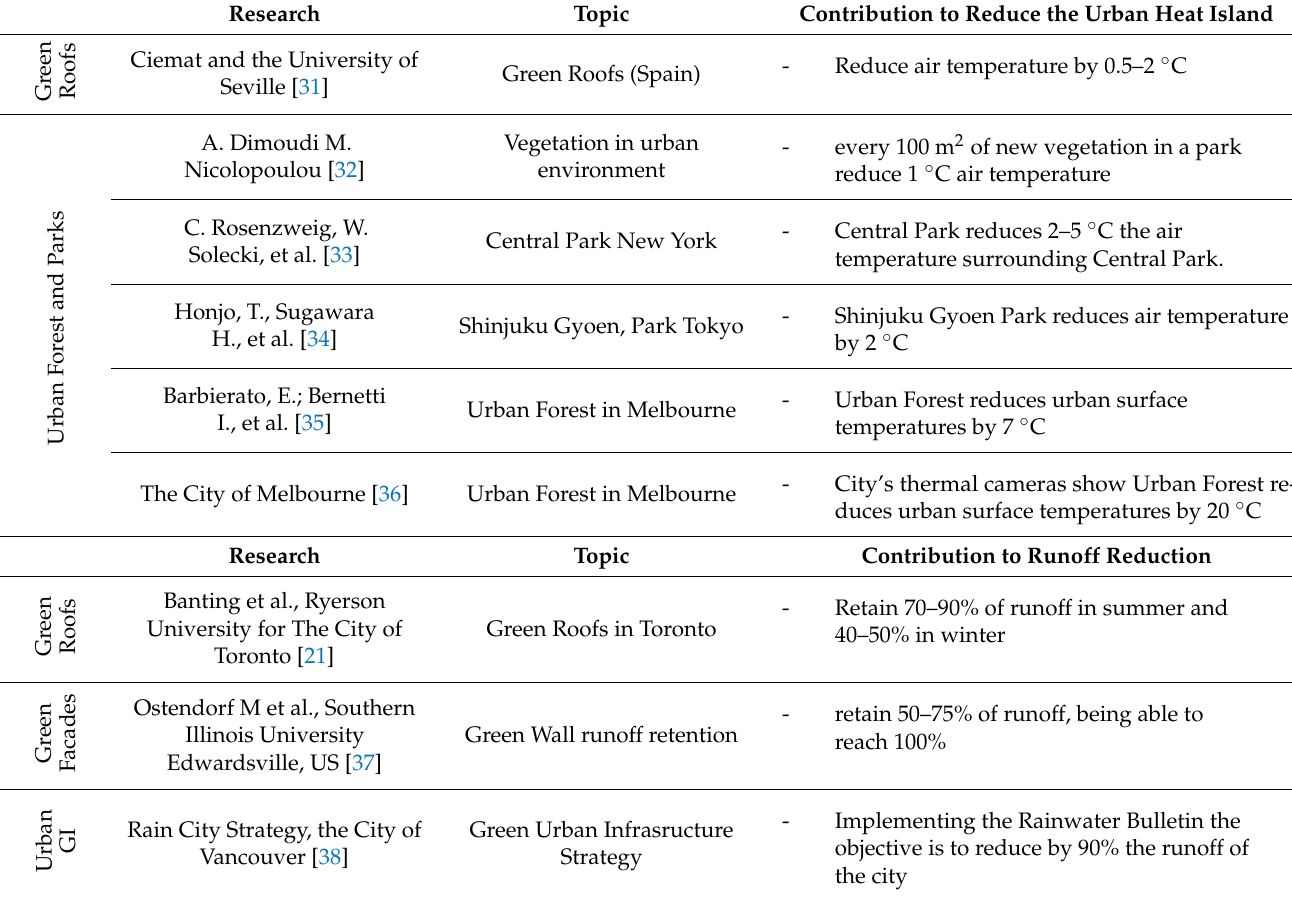
Table A2. Summary table of the contribution to cc adaptation (developed by the